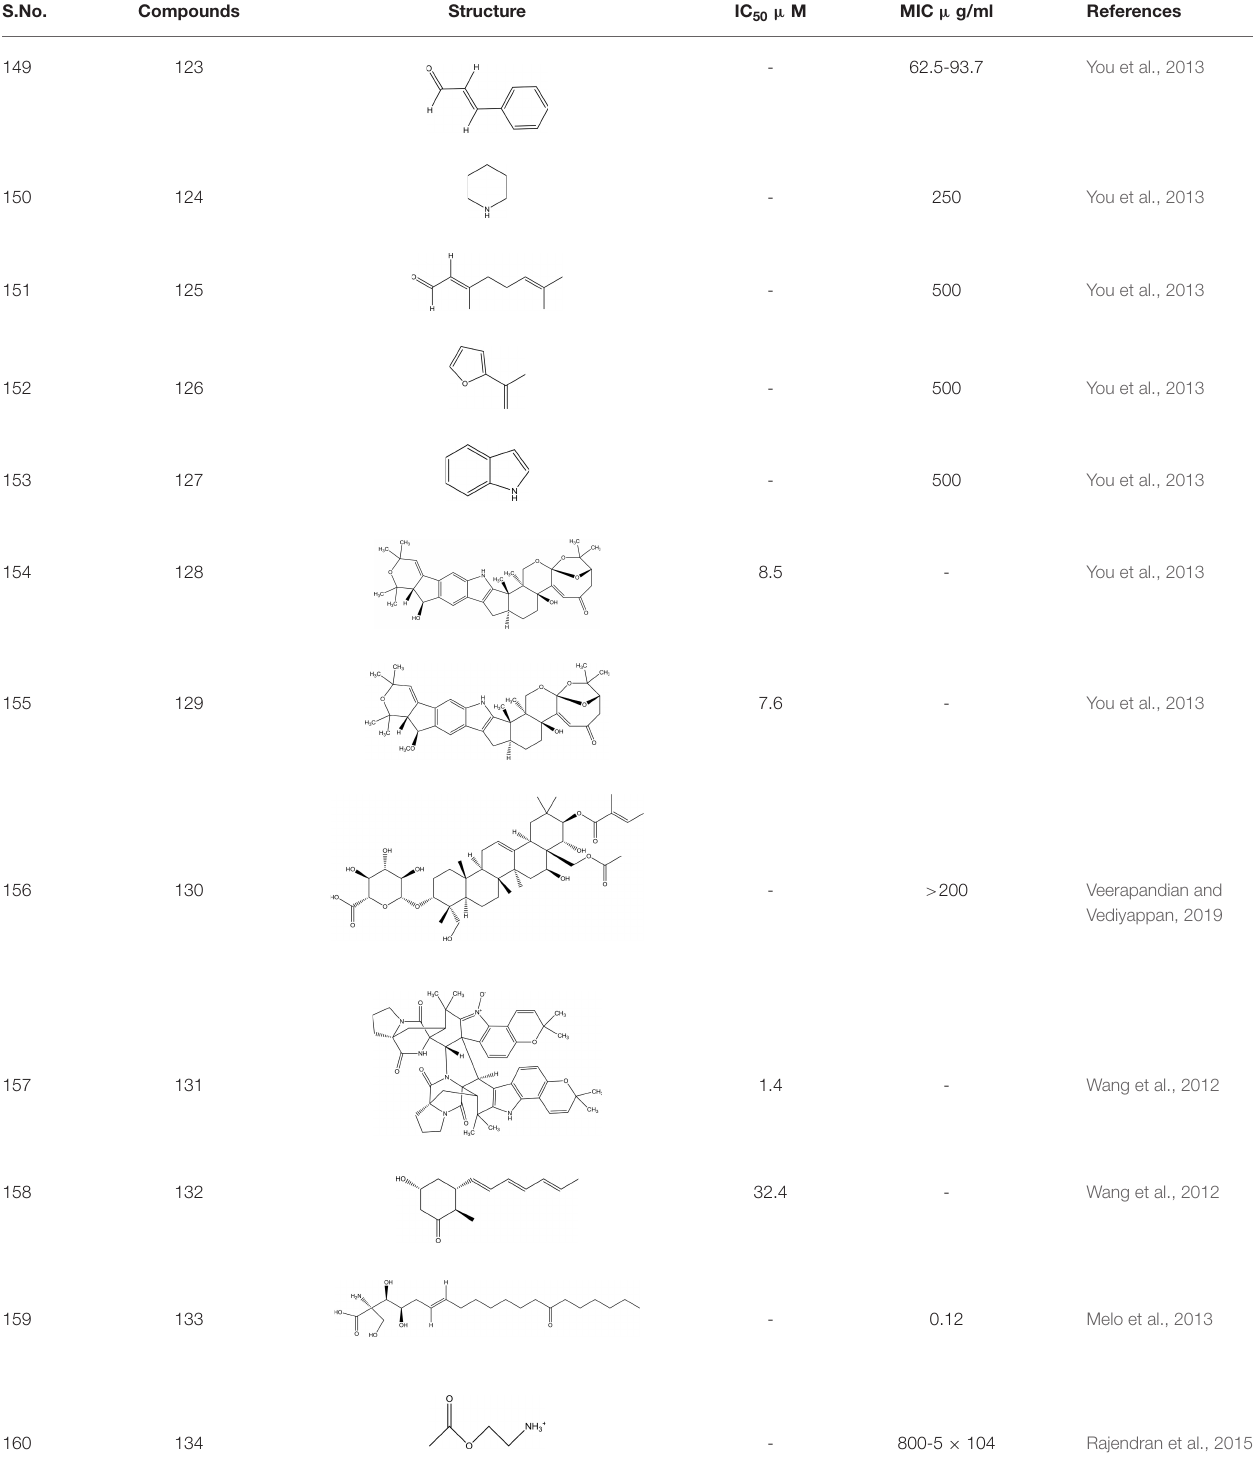
TABLE 9 | Chemical structures and MIC/IC 50 values of small molecule inhibitors (123–137).